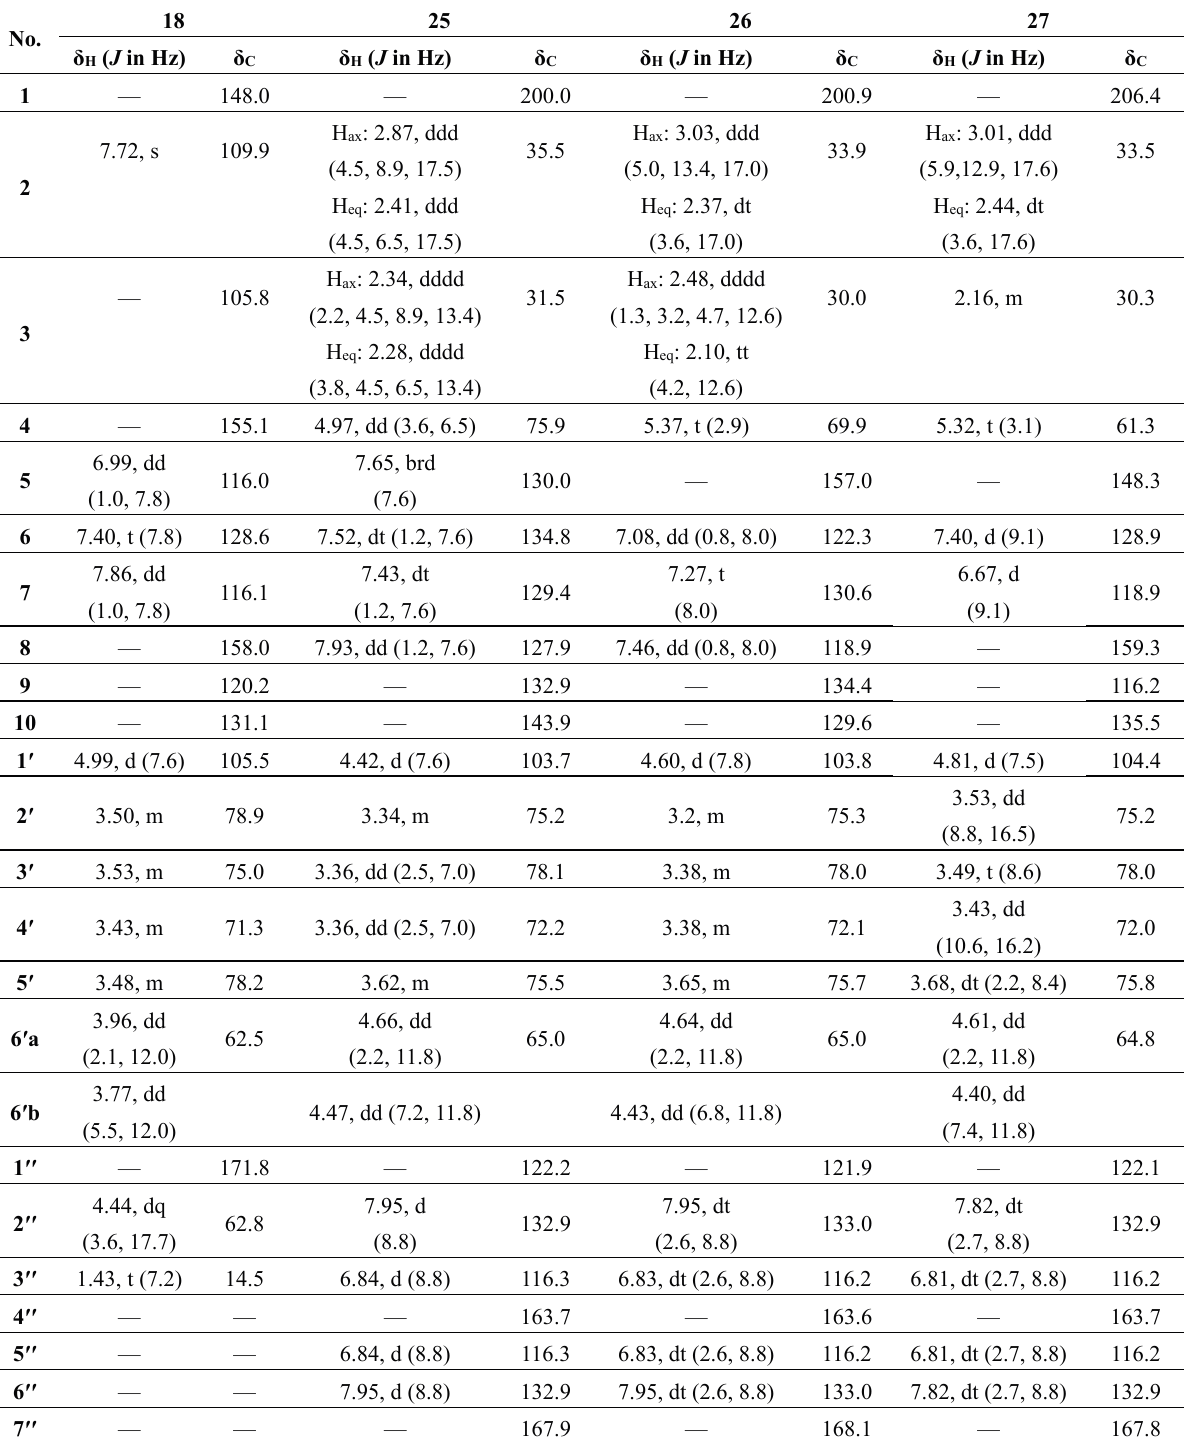
Table 1. 1 H-(400 MHz) and 13 C-(100 MHz) NMR data of 18 , 25 – 27 in CD 3